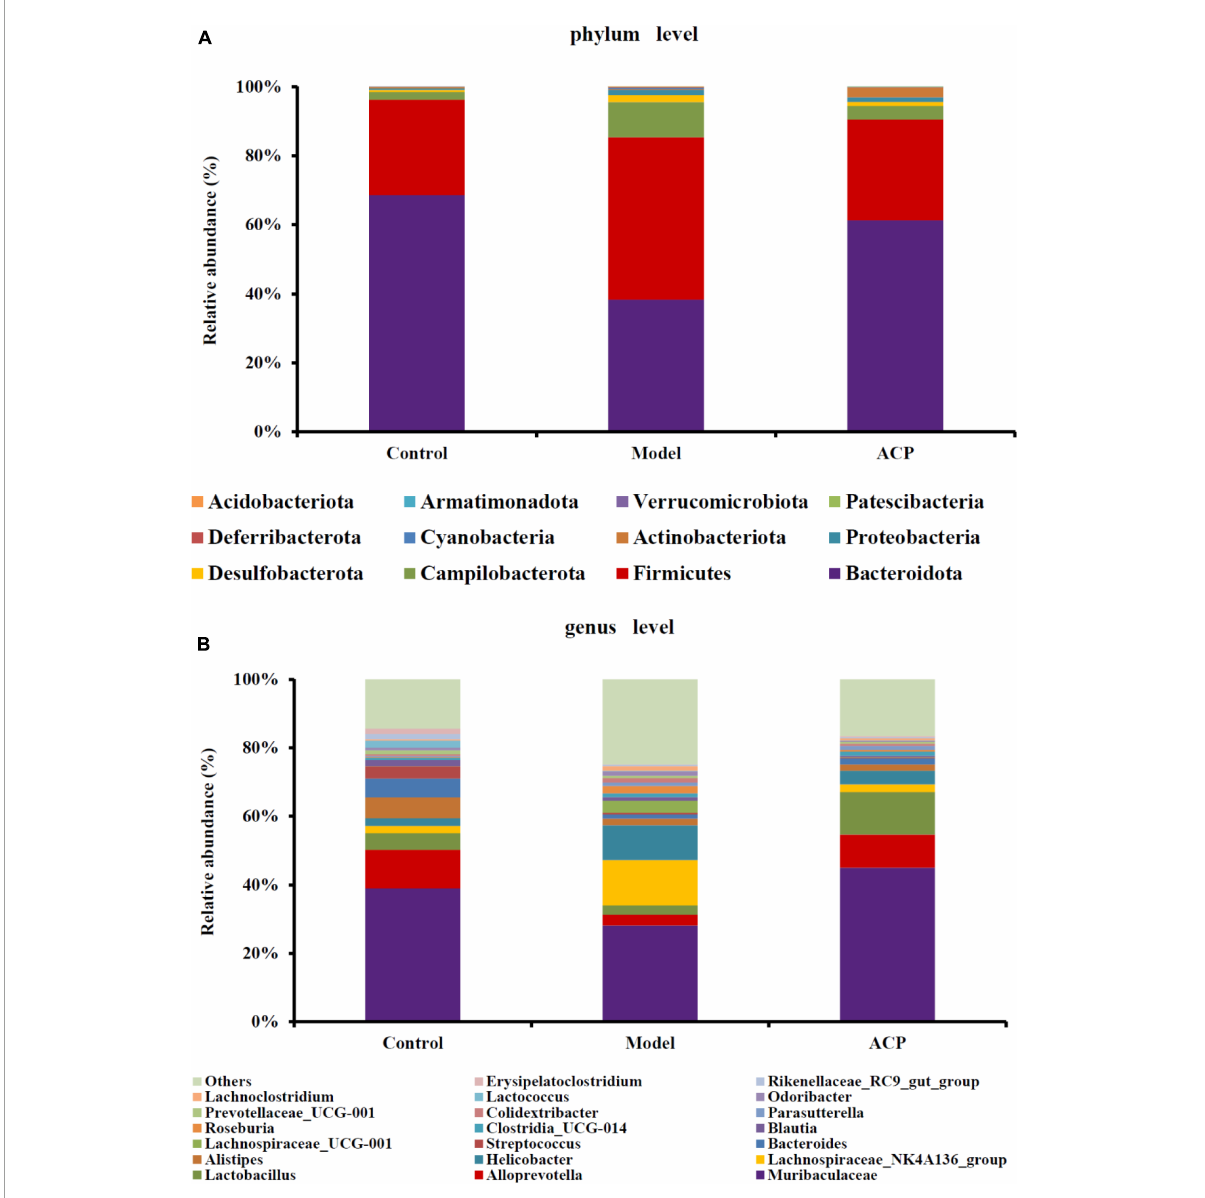
FIGURE5 Effect of Auricularia cornea var. Li. polysaccharides (ACP) supplementation on the composition of gut microbiota in immunosuppressed mice. (A) Phyla level community and (B) genus level